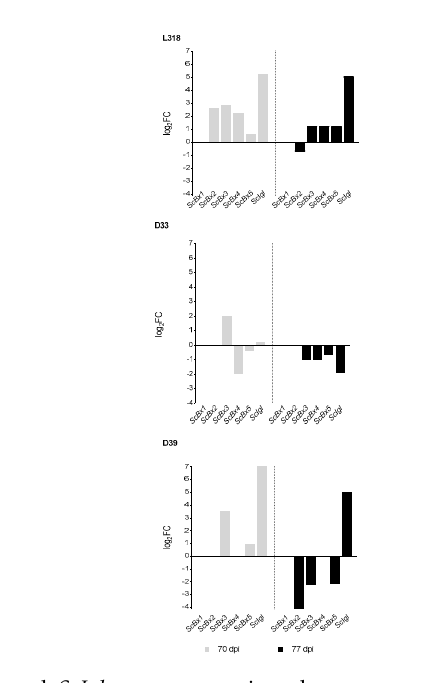
Figure 2. ScBx1–ScBx5 and ScIgl gene expression changes represented as fold changes (FC) in cold-treated plants relative to untreated plants of rye inbred lines L318, D33, and D39 cultivated for 70 and 77 days. The results are presented as means of four biological replications.